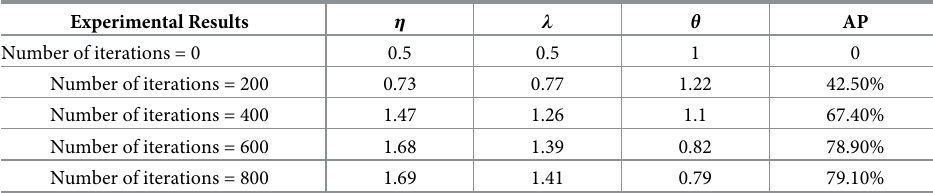
Table 8. Runtime data for the different